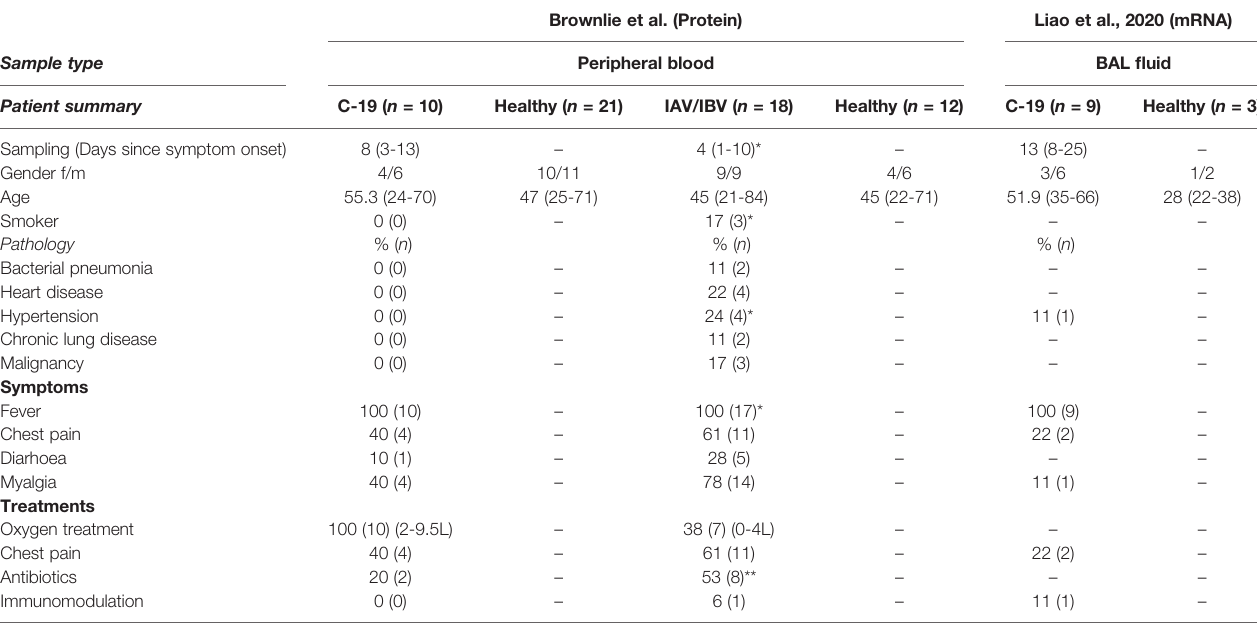
TABLE 1 | Clinical summary and demographics for patient cohorts included in